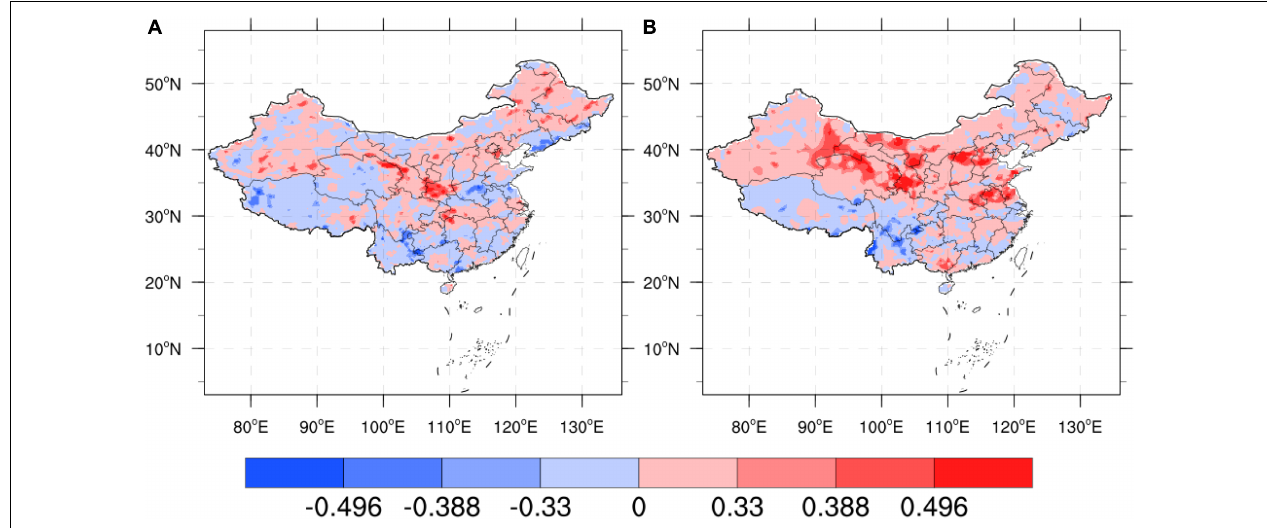
FIGURE 10 | Comparison of TCC before and after CWRF prediction correction for 7 case sets, (A) CWRF prediction and (B) machine learning correction, the color code number is the same as Figure 4 .